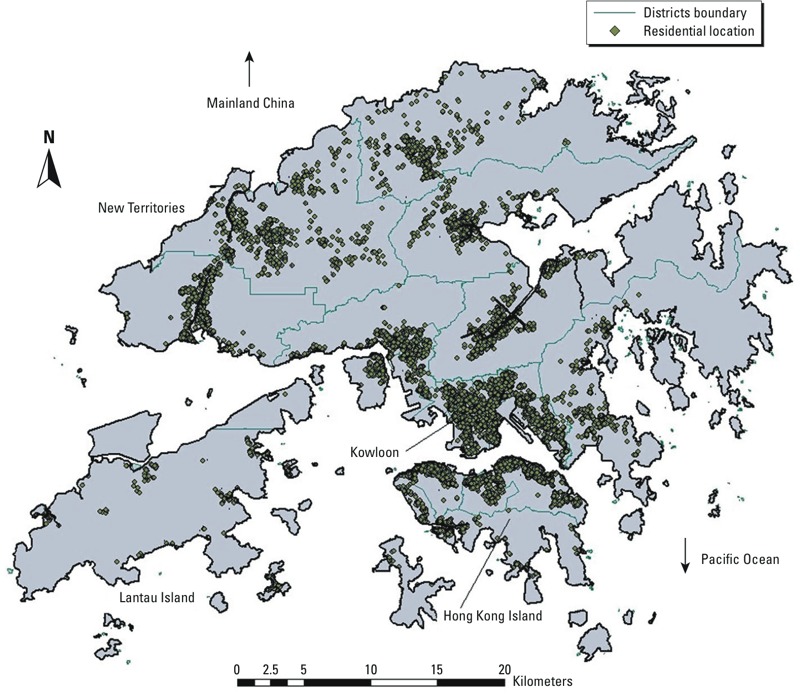
Spatial distribution of geocoded addresses of participants and boundaries of the 18 districts (n = 60,221). Each district has one Elderly Health Centre to provide health service for persons ≥ 65 years of age who have enrolled voluntarily. Those enrolled in 1998–2001 were recruited to this study, and their residential addresses were geocoded into x- and y-coordinates, which fell into 1 × 1 km grids on the Hong Kong map.